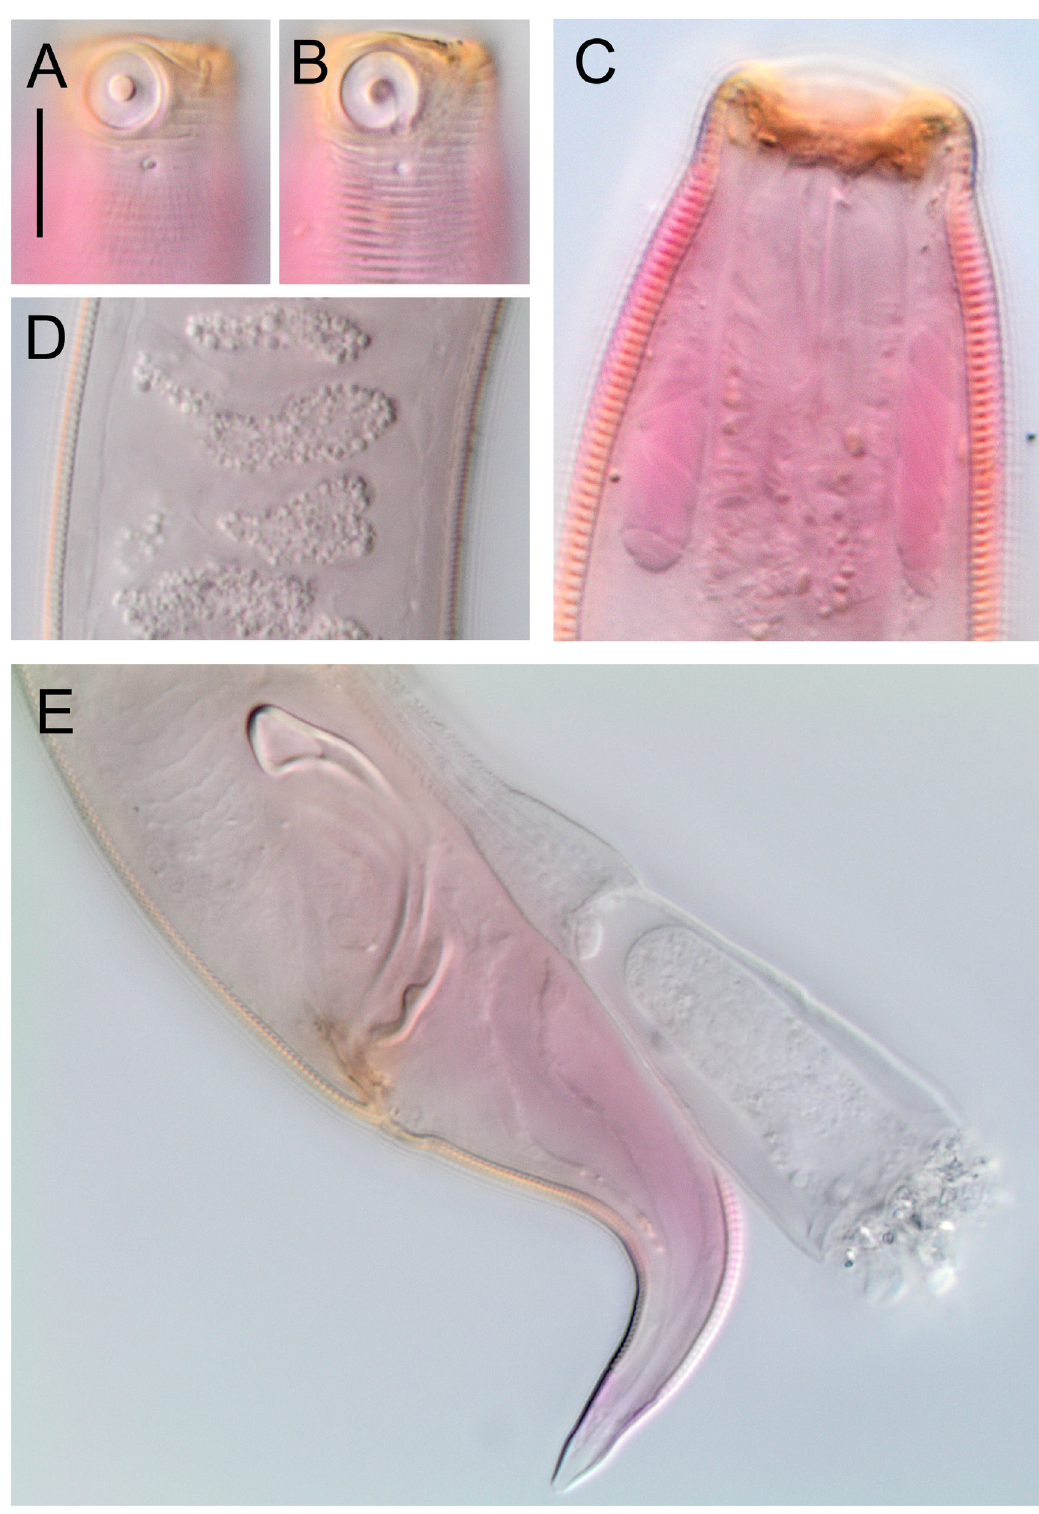
Fig. 3. Spirinia verecunda sp. nov., light micrographs. A . Male head, showing amphideal aperture and and cuticular hair-like structures. B . Male head, showing amphideal fovea. C . Male anterior body region showing buccal cavity and elongated glands. D . Mature sperm cells. E . Posterior body region of male, showing copulatory apparatus and attached protist. Scale bar: A–B, D–E = 10 µ m, C = 8 µ